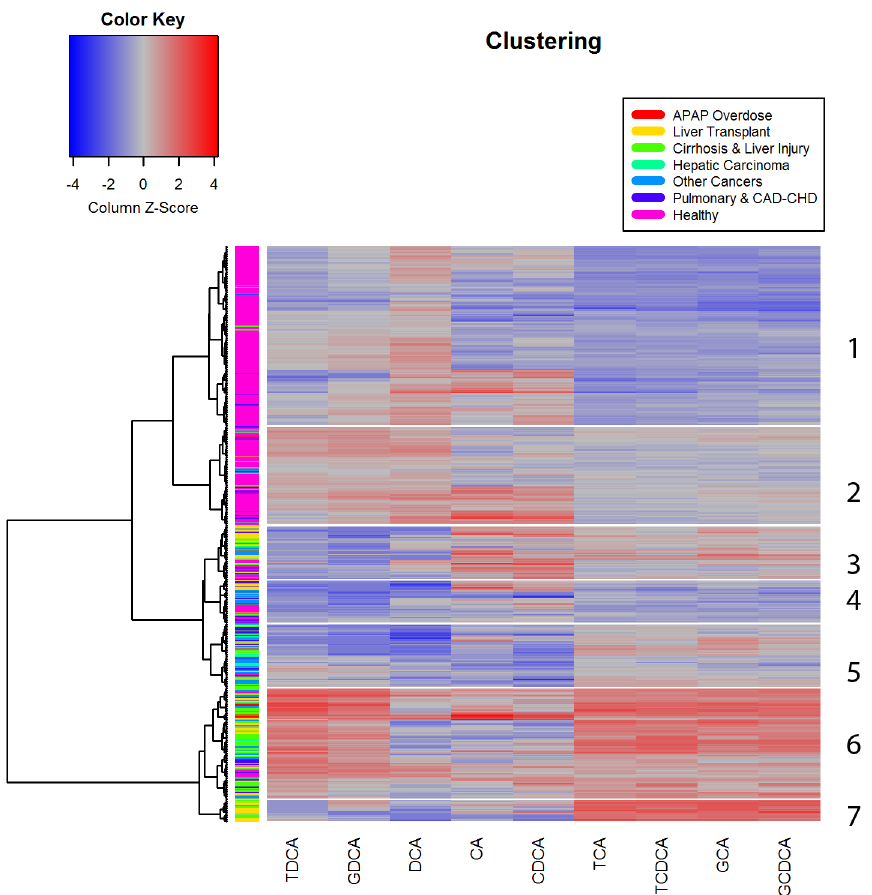
Fig 4. Hierarchical clustering and heat map analysis of 9 individual bile acids. Cluster analysis differentiated a total of 7 clusters, and showed distinct bile acid patterns across different diagnosis groups.